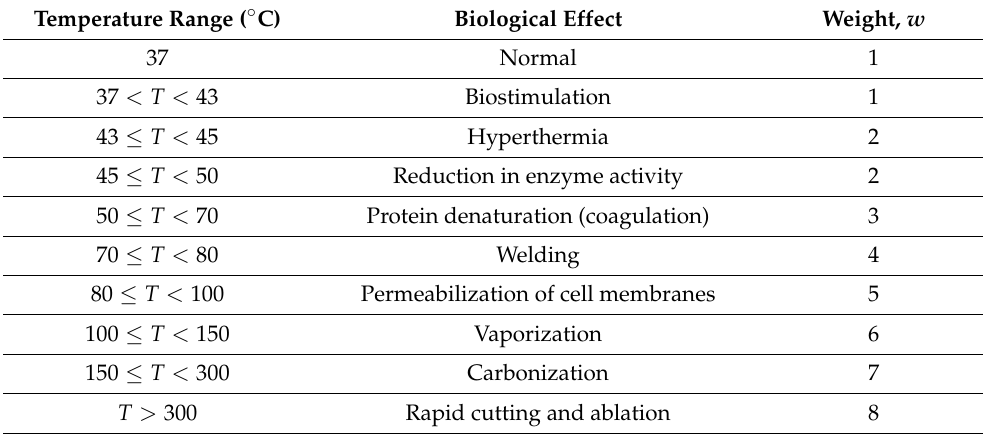
Table 1. Laser-induced thermal effects